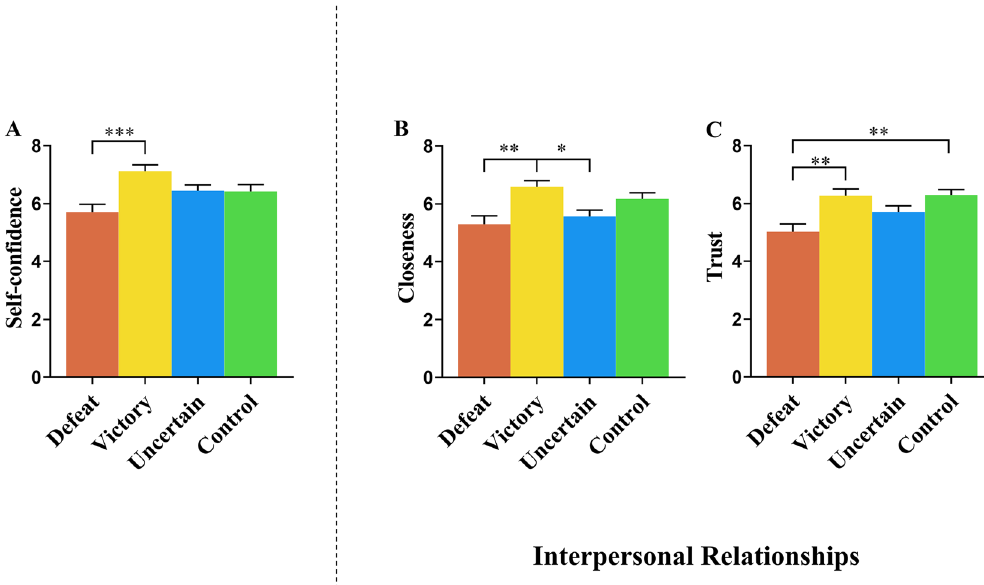
Figure 2. Effect of outcome feedback on participants’ self-reported measures. The graphs in ( A – C ) show mean ratings of self-confidence, closeness, and trust as a function of outcome feedback, respectively. * p < 0.05, ** p < 0.01, *** p < 0.001. Error bars represent ± 1